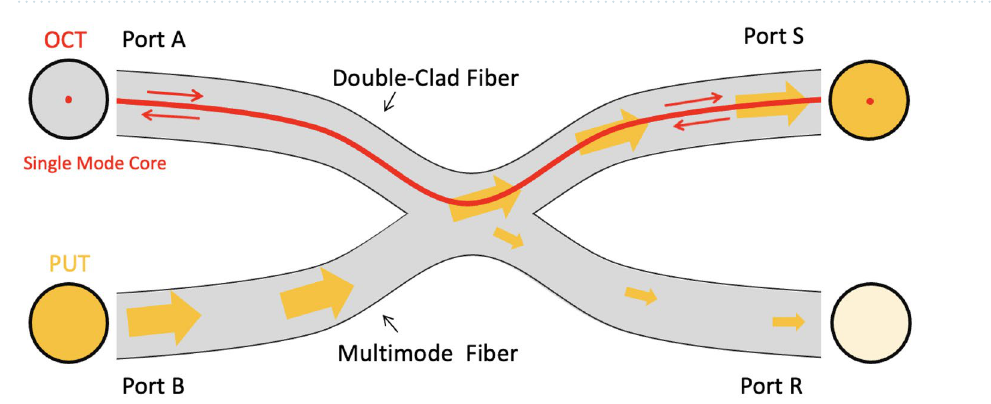
Figure 3. Diagram of Double-clad fiber